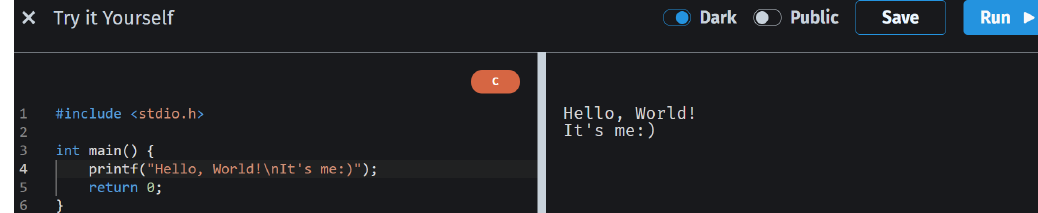
Figure 5: Working with program code in Sololearn.